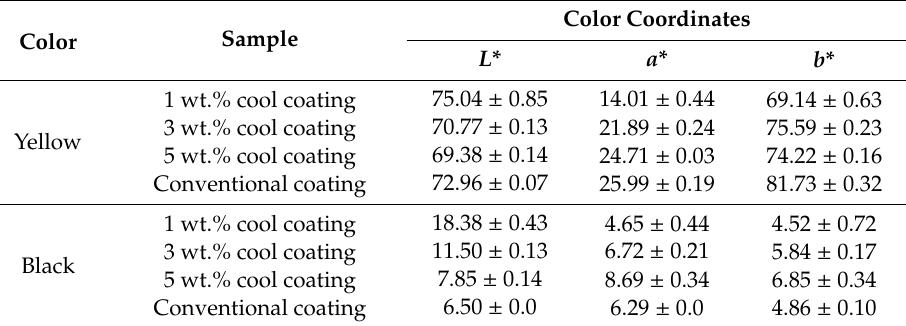
Table 2. Initial color coordinates for each coating sample.